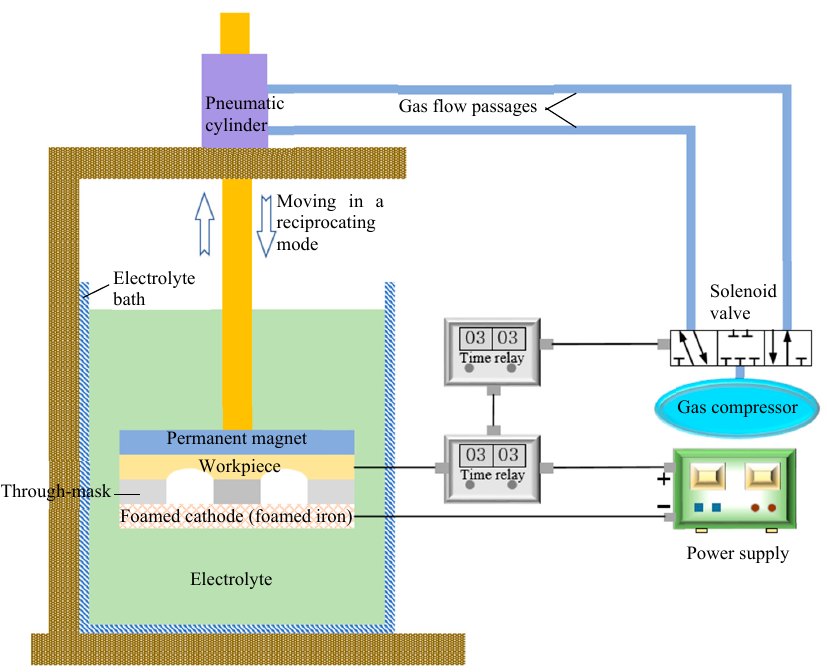
Figure 2. Schematic view of the experimental system for the modified TMEMM process. Table 1. Experimental